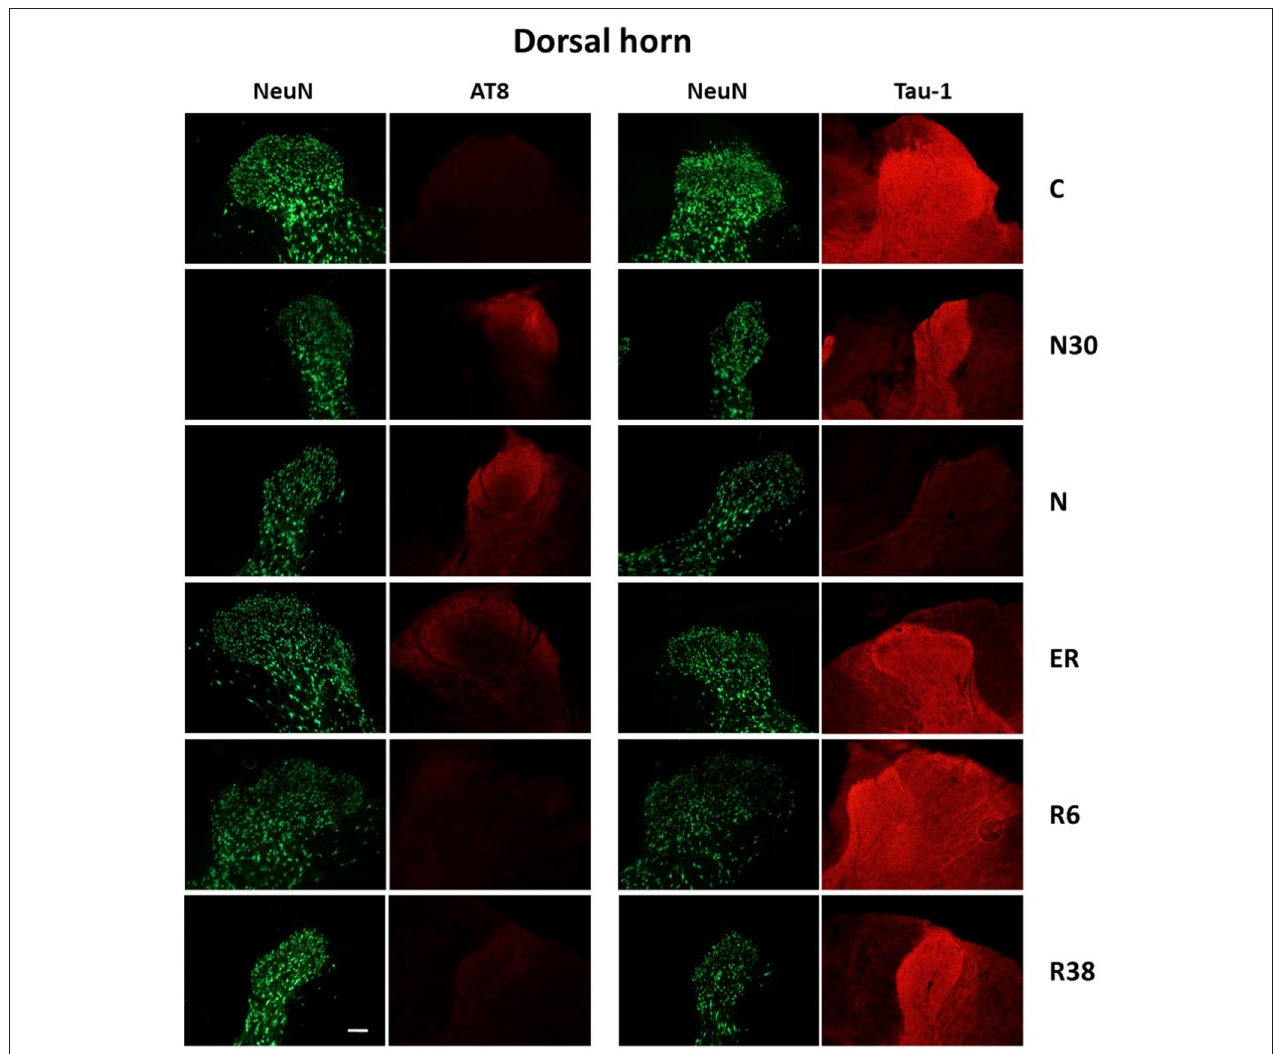
FIGURE 3 | Representative pictures showing the dorsal horn of the spinal cord. Green pictures represent NeuN staining (neuronal maker, secondary conjugated with Alexa-488), for the recognition of the anatomical structure. In the left half of the figure, red pictures represent the same corresponding field depicted in the nearby NeuN column, but stained for AT8 (phosphorylated Tau, secondary conjugated with Alexa-594). In the right half of the figure, red pictures represent the same corresponding field depicted in the nearby NeuN column but stained for Tau-1 (non-phosphorylated Tau, secondary conjugated with Alexa-594). C, control; N30, samples taken during the induction of synthetic torpor (ST), when brain temperature (Tb) reached 30 ◦ C; N, samples taken at nadir of hypothermia, during ST; ER, early recovery, samples taken when Tb reached 35.5 ◦ C following ST; R6, samples taken 6h after ER; R38, samples taken 38h after ER. Calibration bar: 100 µ